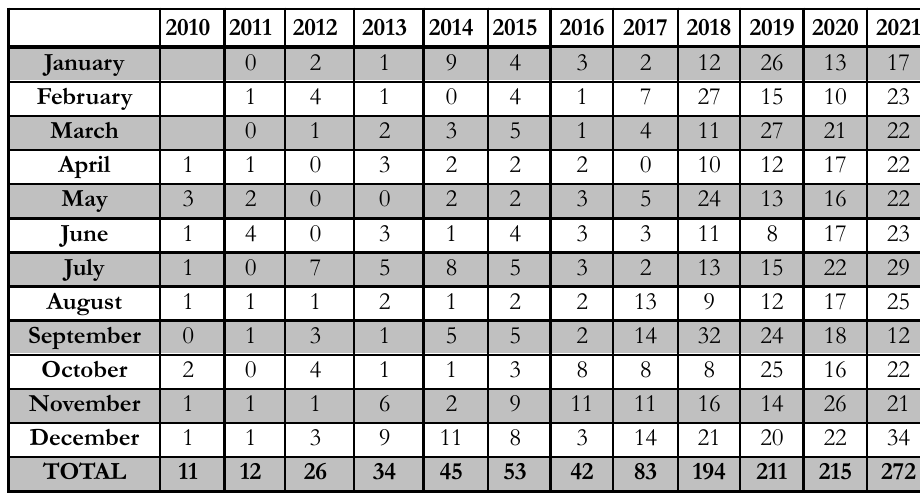
Table 1. Article submissions evolution from 2010 to 2021